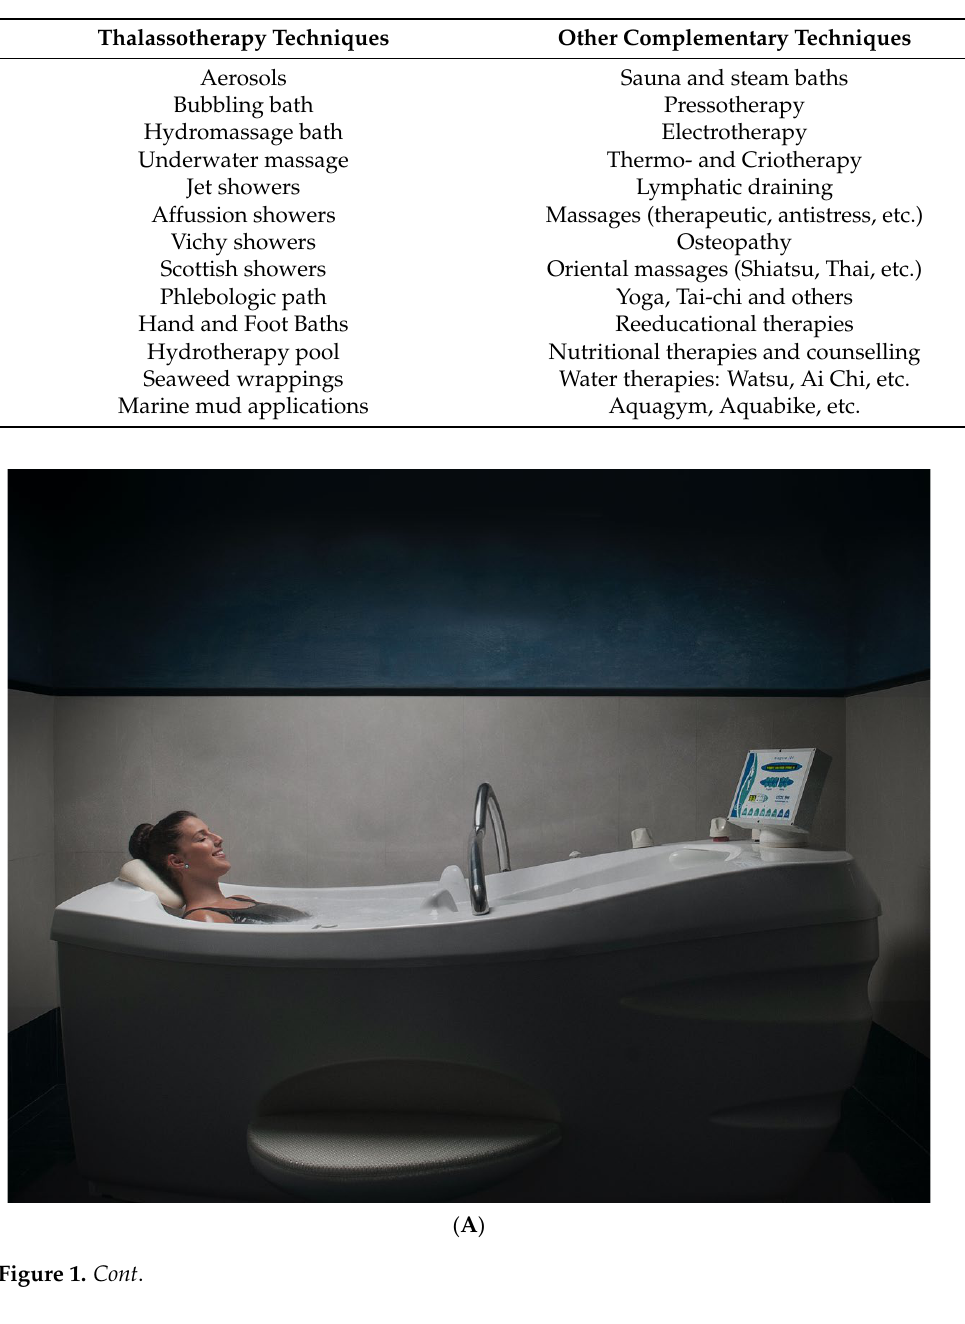
Table 2. Procedures and techniques of thalassotherapy.